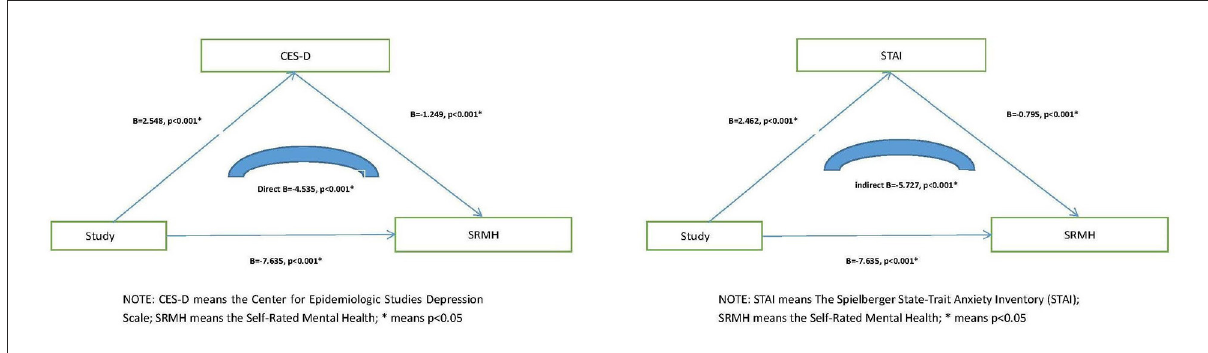
FIGURE3 The relationship between SRMH total score, study, CES-D and STAI total